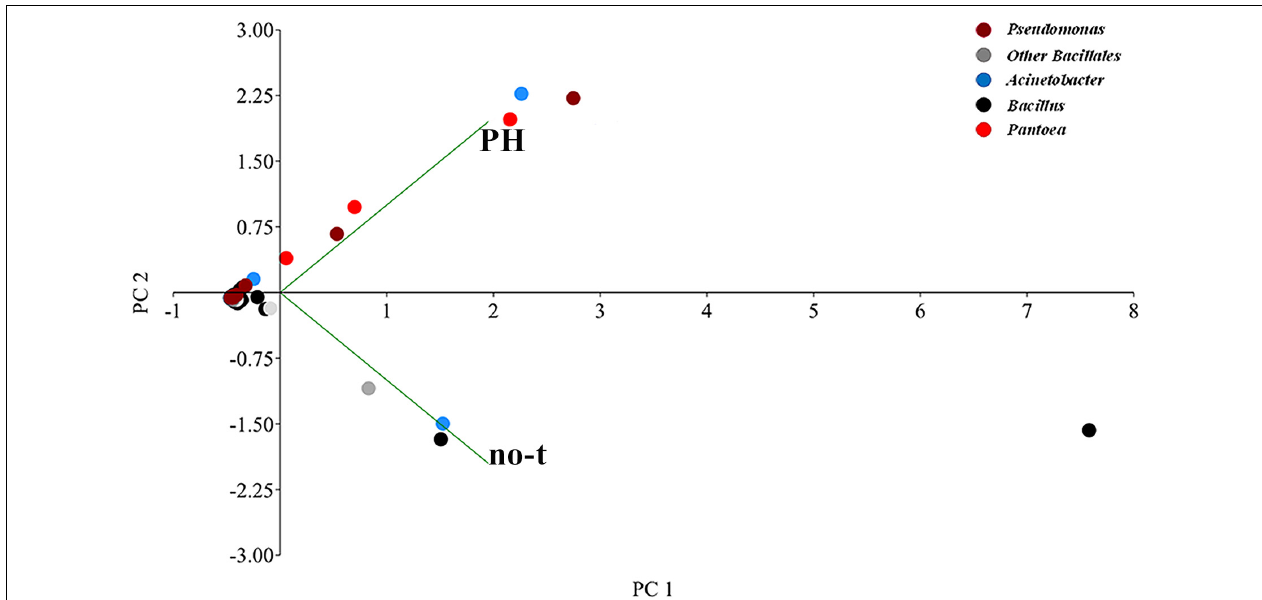
FIGURE 5 | Genus-level principal component analysis (PCA) comparison of the normalized bacterial OTU data. The PCA axes differentiate the PH-treated and no-treated samples according to their microbial composition. Different genera are denoted with different colors. Principal Component 1 and 2 explained 78.4 and 21.5% of the total variations,